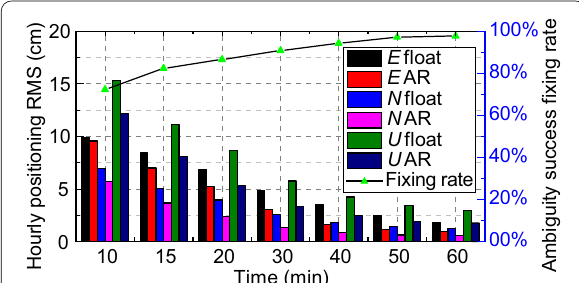
Fig. 12 Hourly static positioning errors and ambiguity success fixing rate